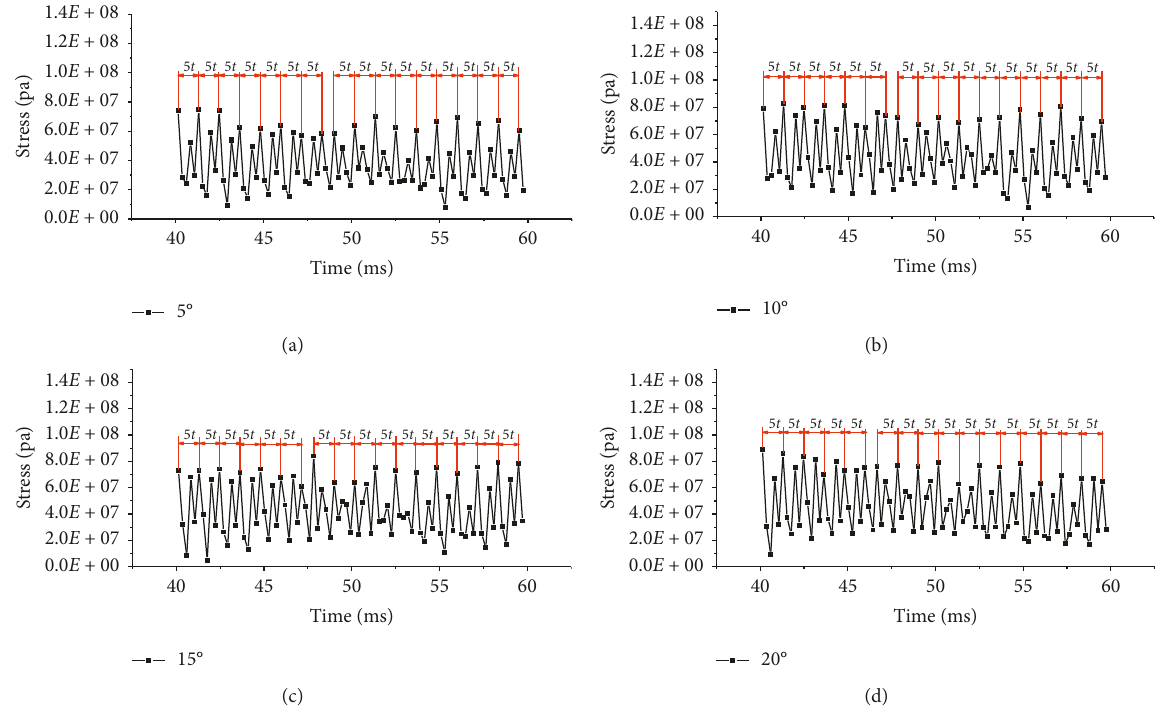
Figure 9: Stress fluctuation cycle period under different tool back angles ( H � 10mm and V � 1.36 m/s): (a) α � 5 ° ; (b) α � 10 ° ; (c) α � 15 ° ; (d) α � 20 ° .